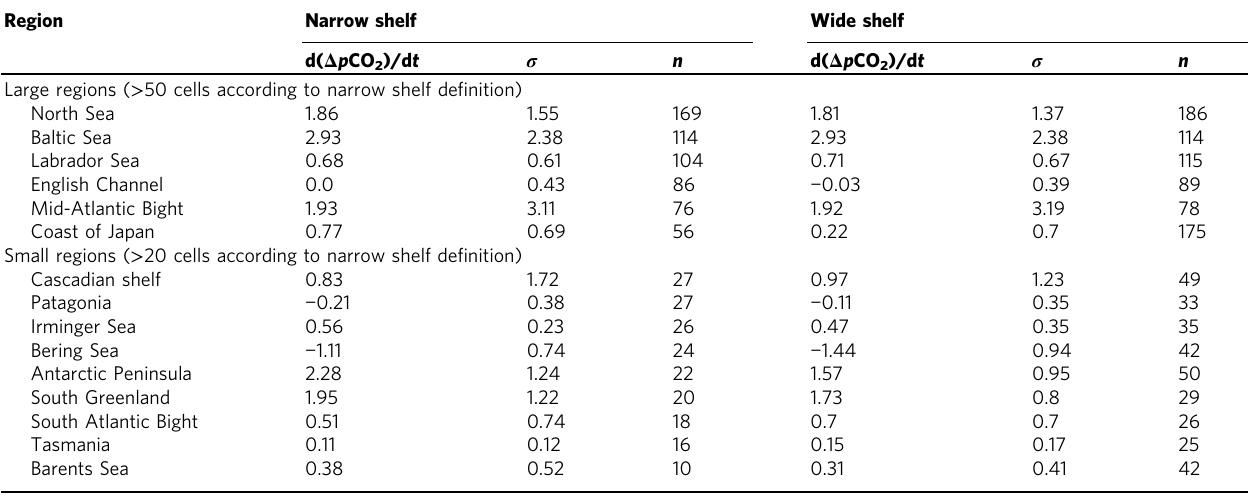
Table 3 Rates of change in Δ p CO 2 in different regions calculated as the average of the rates derived for each cell of the region Region Narrow shelf Wide